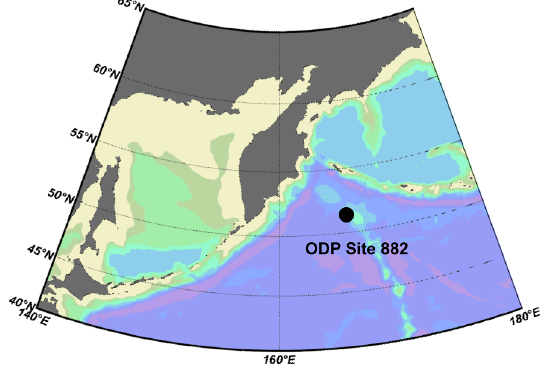
Figure 1. Location of ODP Site 882 in the subarctic north-west Pacific